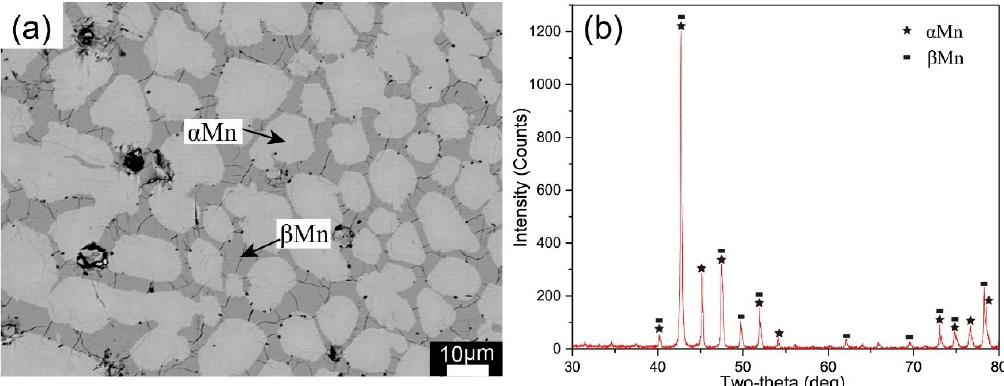
Figure 22. Alloy B25 annealed at 1273K for 60 days: ( a ) BSE images, ( b ) XRD patterns. It can be observed in Figure 23 that the alloy B21, B22 and B24 are respectively in 3 two-phase equilibrium fields: TiMn 4 + α Mn, (Ti,Nb)Mn 2 + α Mn and (Ti,Nb)Mn 2 + β Mn; the alloy B14 is in the solid solution field: (Ti,Nb)Mn 2 .